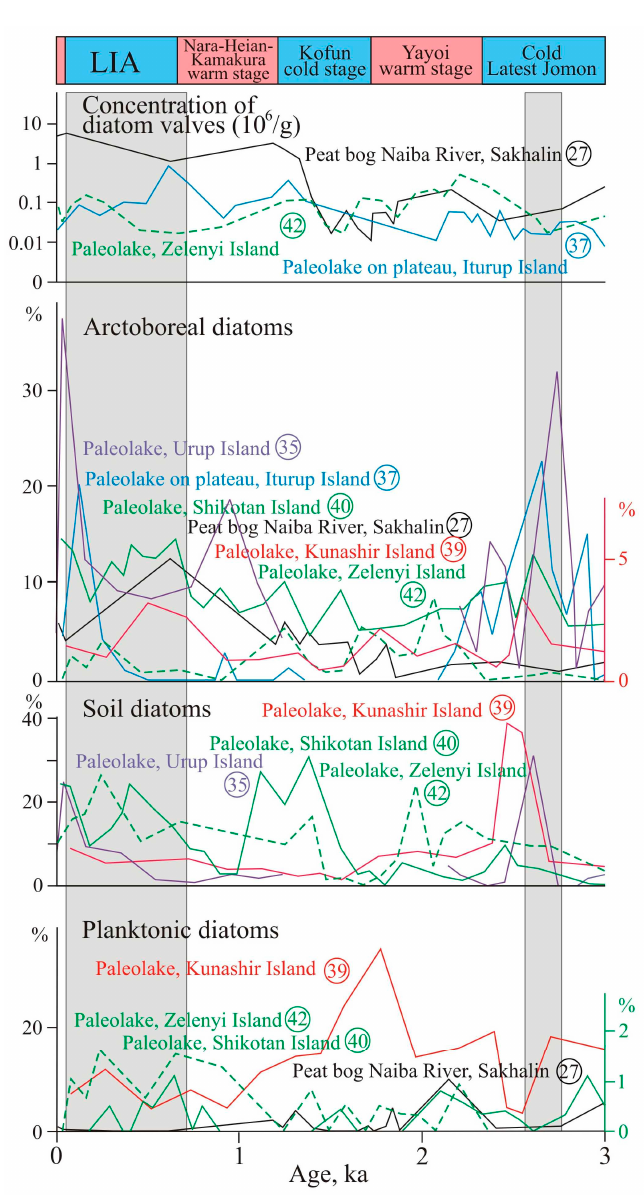
Figure 6. Comparison of results for diatom proxies from peat bog and paleolake sequences on the islands. Japan cold and warm stages in cal. year BP [81]. Grey bars indicate 2800–2600 year BP cold event and the LIA. Numbers of sites according to Figure 2.